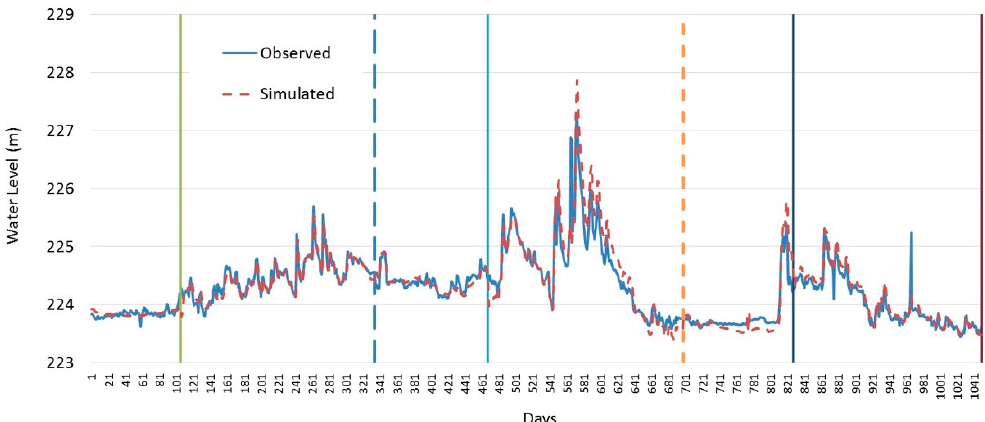
Figure 4. Result comparison between observed value and simulated value of water level at the Mudan River hydrological S2 station.